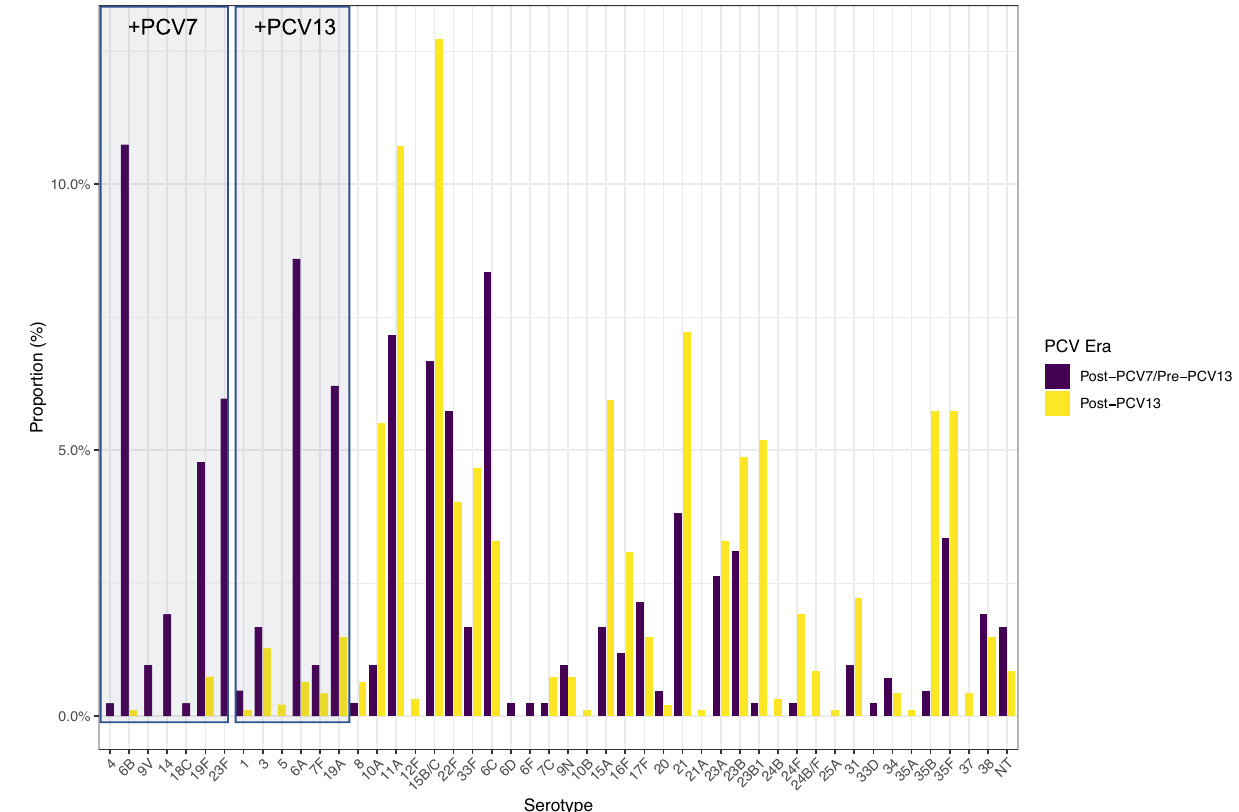
Figure 6. Differences in serotype proportion between the post-PCV7/pre-PCV13 era (purple) and post-PCV13 era (yellow). All PCV serotypes show a marked decrease due to PCV implementation, aside from serotype 3 which has also decreased but to a lesser extent. Notable exceptions to the increase in NVTs are 22F and 6C which have also decreased in the post-PCV13 era, although this followed earlier